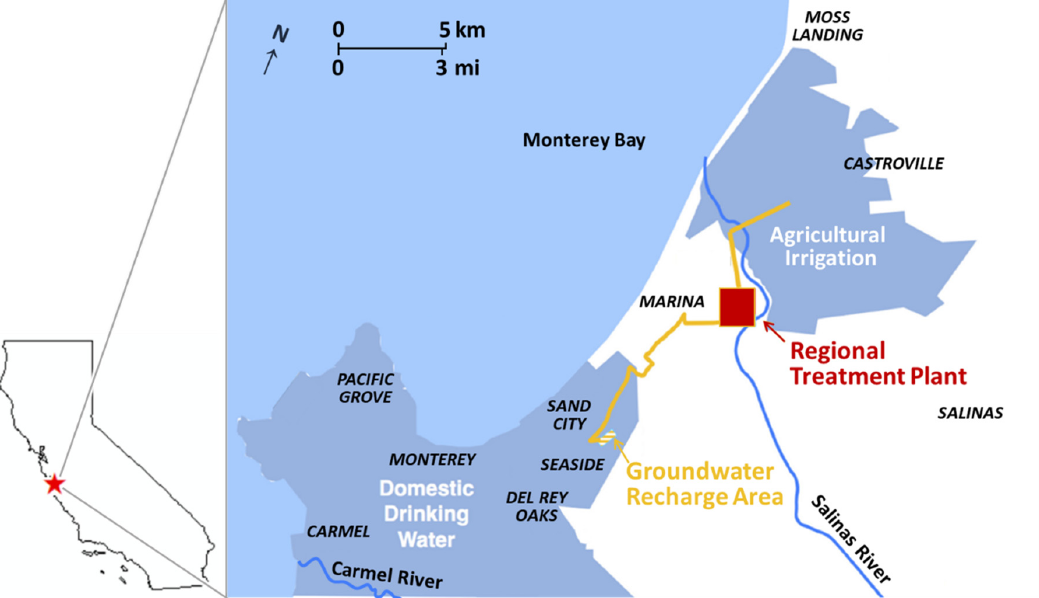
Figure 1. Map of Monterey area rivers, communities, and regional treatment center. Customer areas receiving recycled water are shaded in blue (adapted from [13]).